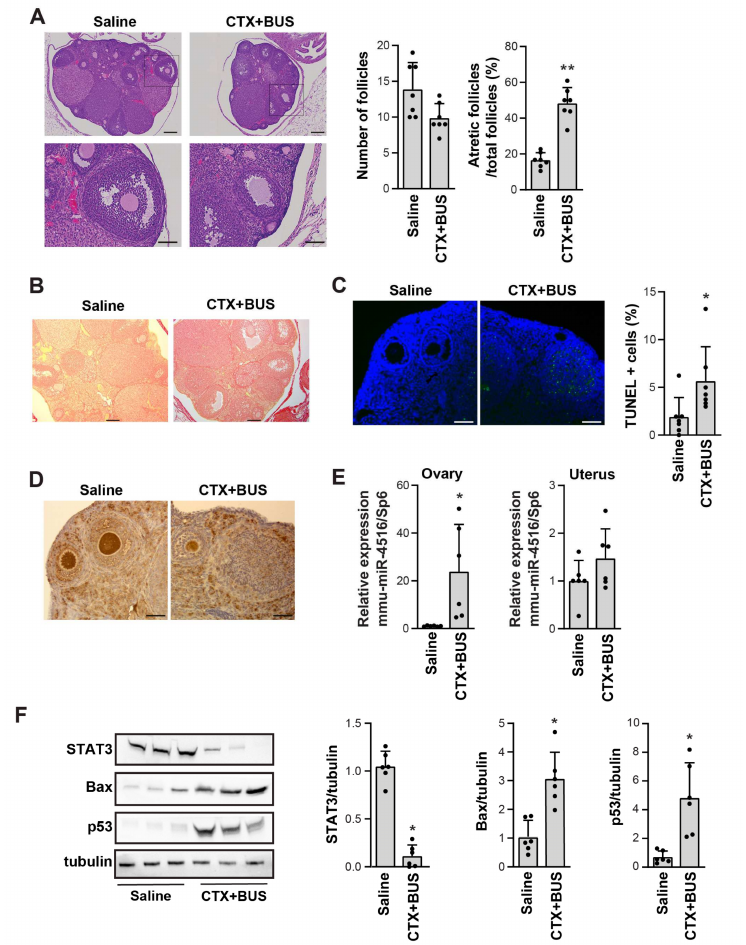
Figure 4. Increase in miR-4516 expression in a chemotherapy-induced premature ovarian insufficiency (POI) mouse model. ( A ) Representative hematoxylin-and-eosin-stained images of the ovaries from saline- and CTX+BUS-treated mice ( n = 7). Scale bar = 200 µ m in the upper panel and 80 µ m in the lower panel. ( B ) Representative images of Sirius red staining in the ovaries from saline- and CTX+BUS-treated mice. Scale bar = 200 µ m. ( C ) Representative images of the TUNEL assay in the ovaries from saline- and CTX+BUS-treated mice. Scale bar = 80 µ m. TUNEL-positive cells were counted by using ImageJ software ( n = 7). ( D ) Representative immunohistochemistry images of Ki67 expression in the ovaries from saline- and CTX+BUS-treated mice. Scale bar = 80 µ m. ( E ) Relative expression of mmu-miR-4516 in the ovaries and uteri from the saline- and CTX+BUS-treated mice were analyzed by using qRT-PCR. Relative miRNA expression was normalized by using UniSp6 as an internal control ( n = 6). ( F ) Western blot analysis of STAT3, Bax, and p53 expression in the ovaries of saline- and CTX+BUS-treated mice. The relative protein level in ( F ) was normalized to tubulin levels (mean ± SD; n = 6). Asterisks (*, **) indicate significant differences ( p < 0.05, p < 0.01, respectively) when compared to saline-injected